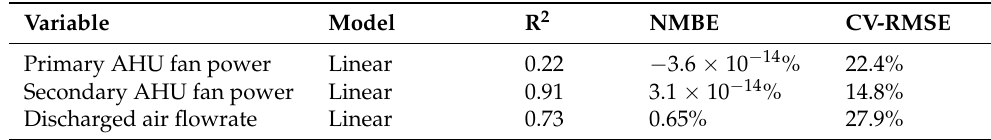
Figure 9. Discharged air flowrate as a function of the cooling load from the chilled water system under baseline operation. Table 3. Accuracy of fan power and discharged air flowrate